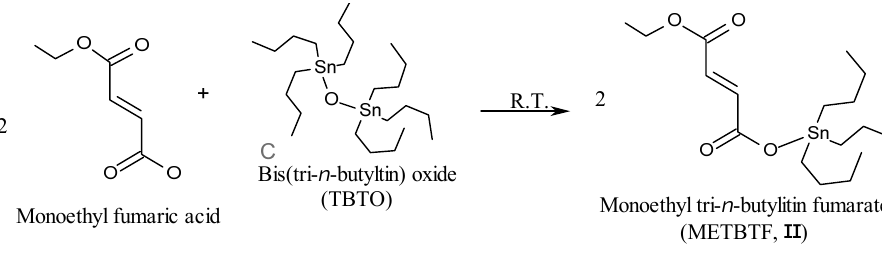
Table 1. Elemental microanalyses of monomers I and II . Monomer